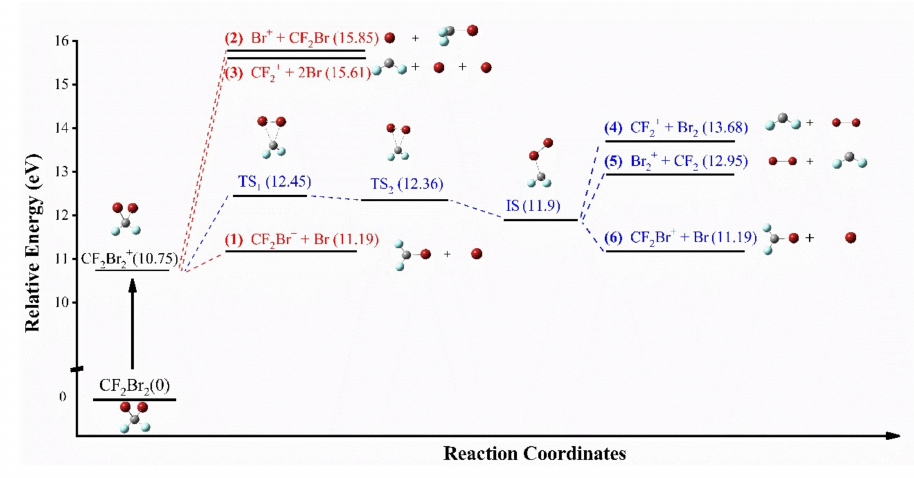
Figure 4. Ab initio calculation of dissociation pathways of the singly charged CF 2 Br 2 +